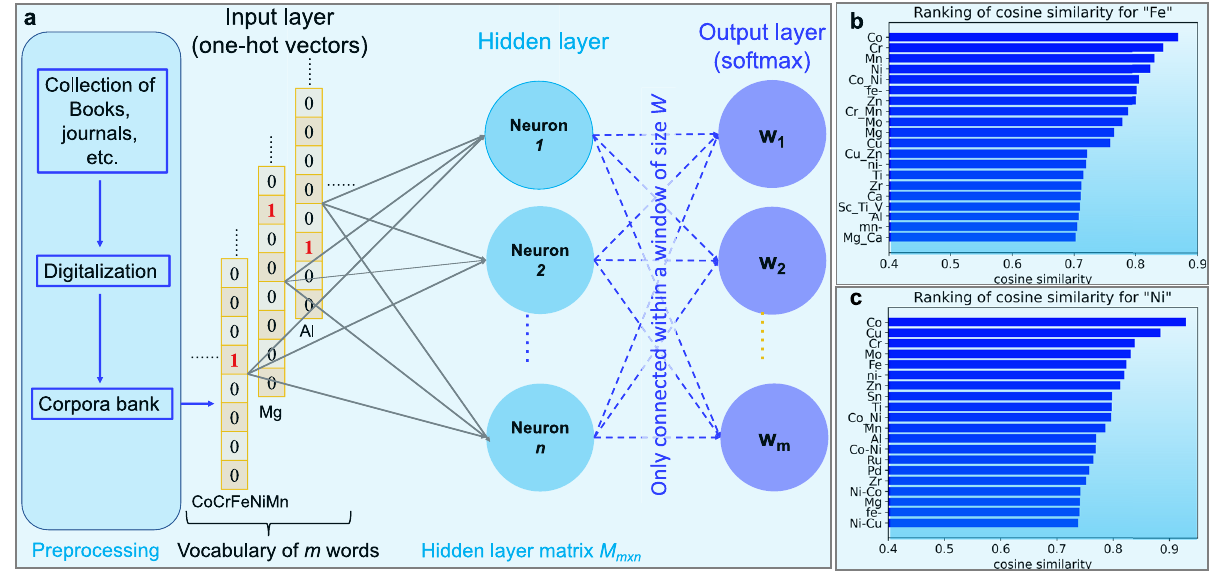
Fig. 1 | Schematic for the word-embedding model (skip-gram). It has a neural- network structure but with only one hidden layer between the input and output layers 21,22 ( a ). The training data fed into the model are the processed corpora downloaded from an online database 41 . The corpora are fi rst tokenized into sepa- rate words or phrases (combinations of two ormorewords with unique meanings) and then translated into vectors. In the one-hot representative of a word vector, each word is represented by a sparse vector with only one nonzero element.